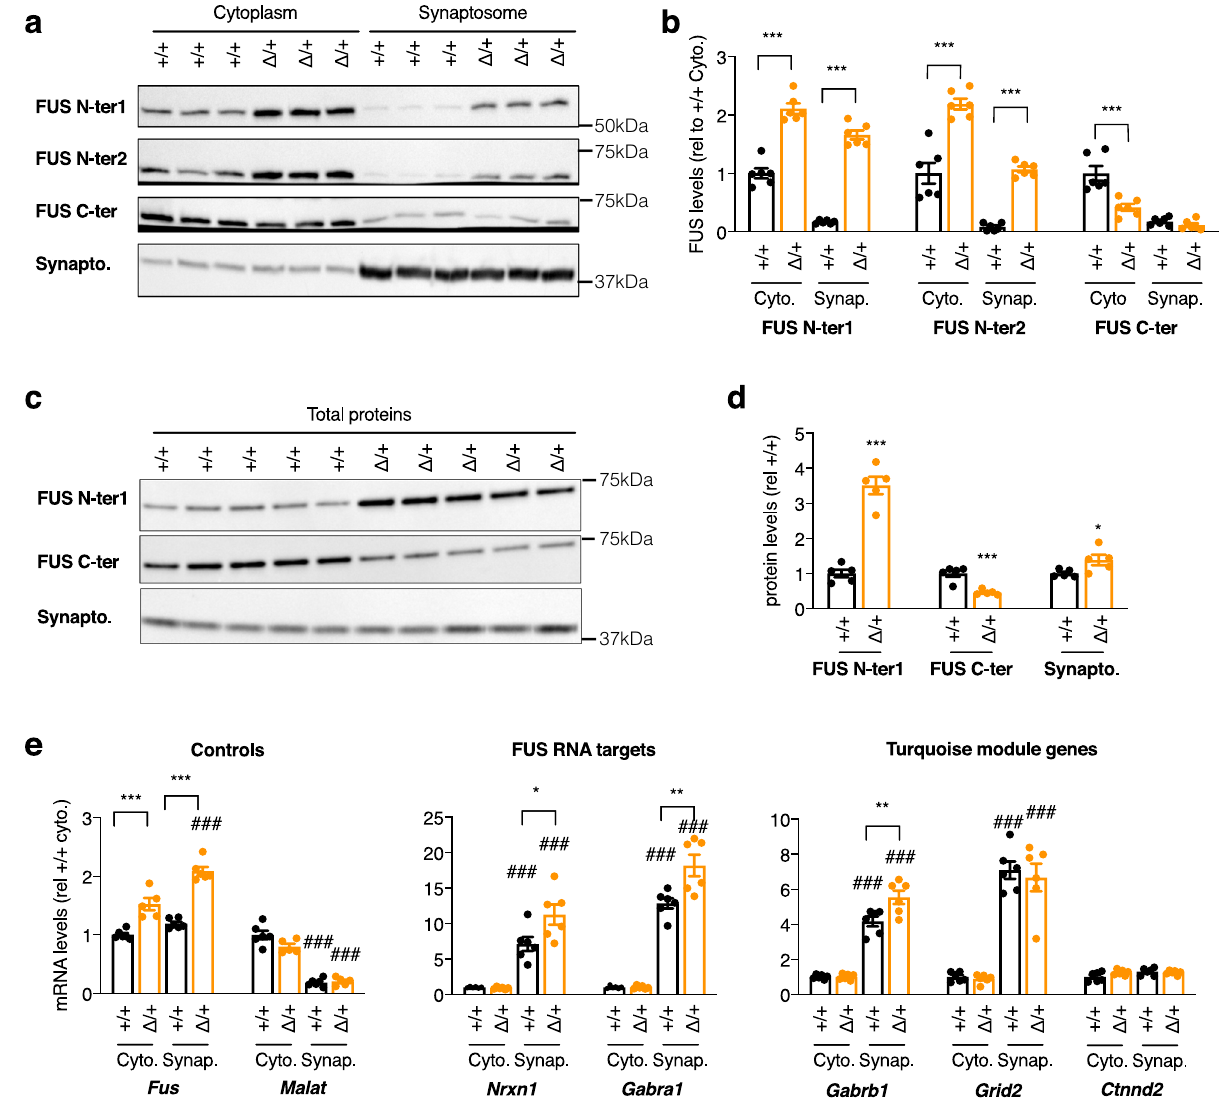
Fig. 7 FUS accumulates in synaptosomes of Fus Δ NLS/ + mice and alters synaptosomal levels of a subset of its targets. a, b Representative western blot images ( a ) and respective quanti fi cations ( b ) of cytoplasmic ( a , left) or synaptosome ( a , right) extracts from Fus + / + ( + / + ) or Fus Δ NLS/ + ( Δ / + ) mice (4 months of age,) using two antibodies recognizing the N-terminal part of the FUS protein (FUS N-ter1 and FUS N-ter2), the C-terminal part of FUS (encoding the NLS, FUS C-ter) or synaptophysin protein to show enrichment in synaptic proteins in the synaptosome fraction. N = 6 Fus + / + mice and N = 6 Fus Δ NLS/ + mice were analyzed. Data are presented as mean ± SEM. One-Way ANOVA with Tukey post-hoc test. *** p < 0.0001 Please note that the FUS western blots were run on independent gels, to avoid stripping and reprobing on the same membrane for the same protein. Each of these gels were controlled for equal loading using StainFree markers, that are provided in the source data. c, d Representative western blot images ( c ) and respective quanti fi cations ( d ) of total extracts ( c ) from Fus + / + ( + / + ) or Fus Δ NLS/ + ( Δ / + ) mice (4 months of age,) using the same antibodies as in panel a . N = 5 Fus + / + mice and N = 5 Fus Δ NLS/ + mice were analyzed. Data are presented as mean ± SEM. Two-tailed Unpaired Student ’ s t -test. N-ter1: p < 0.0001; C-ter: p -value: p = 0.0006; Synaptophysin: p = 0.0411. e mRNA levels of the indicated genes in RNAs extracted from cytoplasmic (Cyto.) or synaptosome (Synap.) extracts from Fus + / + ( + / + ) or Fus Δ NLS/ + ( Δ / + ) frontal cortex from 4-months-old female mice as assessed using RT-qPCR. N = 6 Fus + / + mice and N = 5 Fus Δ NLS/ + mice were analyzed. Data are presented as mean ± SEM. Genes are grouped by categories (controls, established FUS RNA targets, and genes belonging to the Turquoise module). All quanti fi cations are presented relative to the + / + cytoplasmic RNA levels set to 1. One-way ANOVA with Tukey post-hoc test. Fus: *** p < 0.0001 vs corresponding wild-type fraction; ### p < 0.0001 vs corresponding cytoplasmic fraction of the same genotype. Malat: ### p = 0.0001 vs corresponding cytoplasmic fraction of the same genotype. Nrxn1 * p = 0.0140 vs corresponding wild-type fraction; ### p < 0.0001 vs corresponding cytoplasmic fraction of the same genotype. Gabra1: ** p = 0.0012 vs corresponding wild-type fraction; ### p < 0.0001 vs corresponding cytoplasmic fraction of the same genotype. Gabrb1: ** p = 0.0029 vs corresponding wild-type fraction; ### p < 0.0001 vs corresponding cytoplasmic fraction of the same genotype. Grid2: ### p < 0.0001 vs corresponding cytoplasmic fraction of the same genotype. Ctnnd2: no signi fi cant differences observed ( p > 0.05). Source data are provided as a Source Data fi